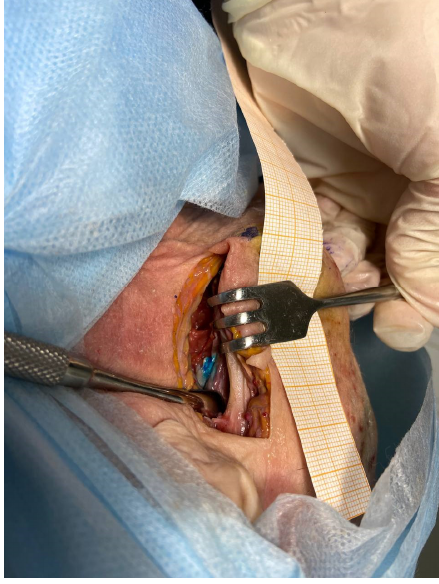
Figure 6. Dissection and injection success verification.